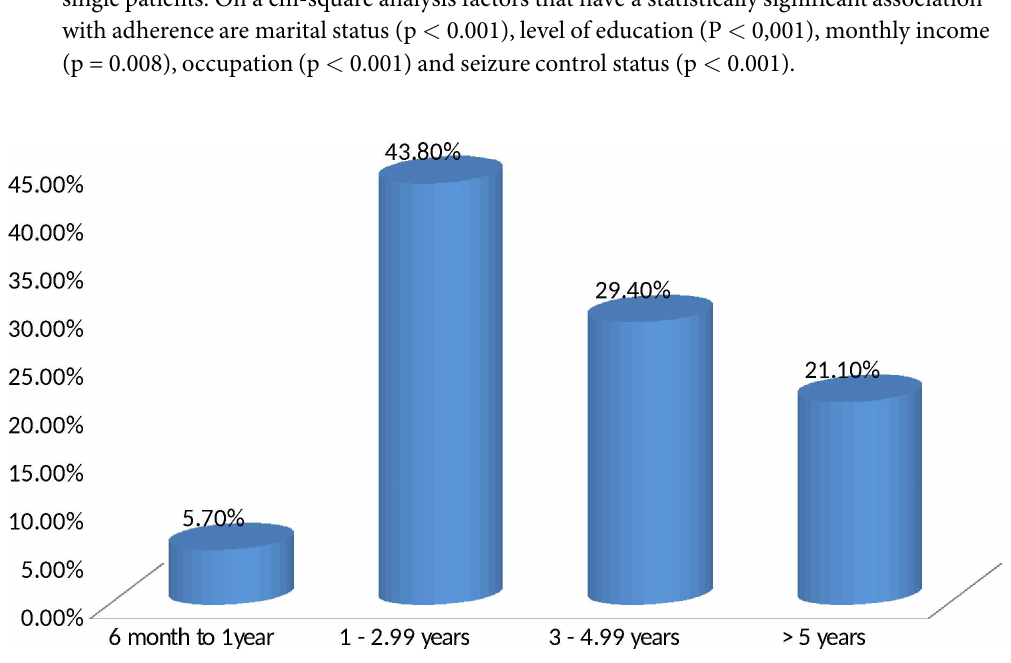
Fig 2. Duration of epilepsy treatment of epileptic patients at Yirgalem General Hospital.